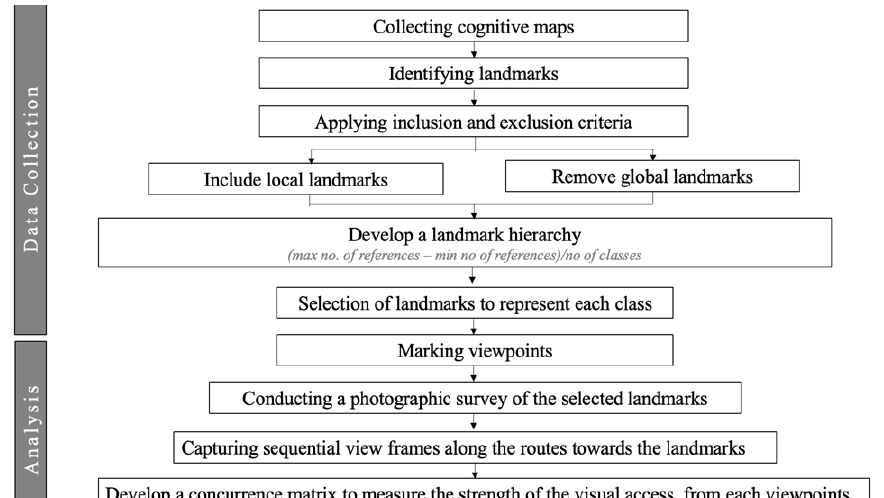
Figure 3. Methodological